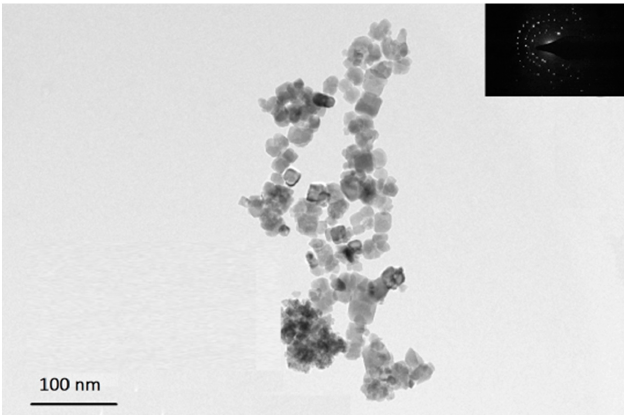
Figure 2. TEM image of SrTiO 3 nanocubes. The inset highlights the SAED pattern of SrTiO 3 .